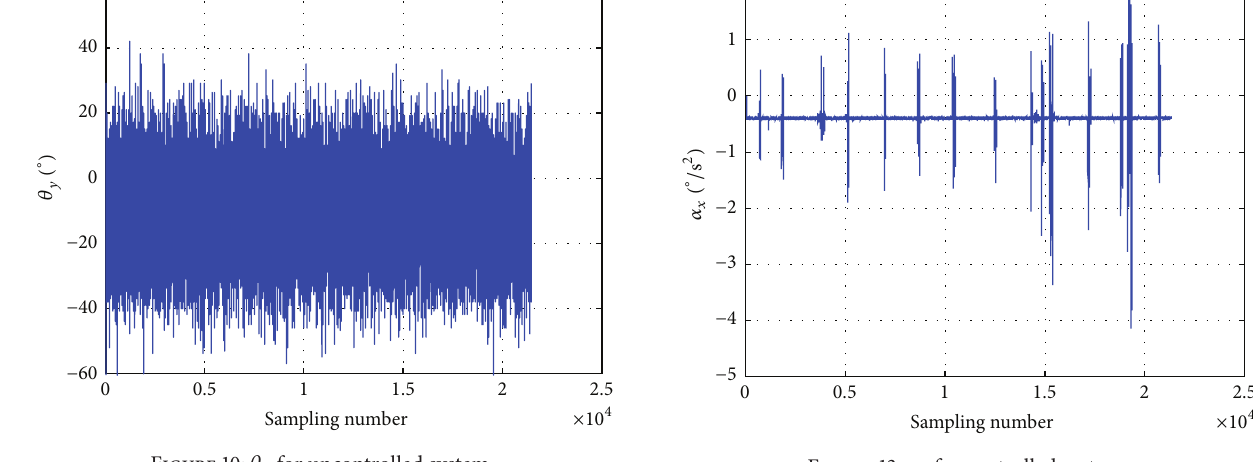
Figure 13: 𝛼 𝑥 for controlled system.